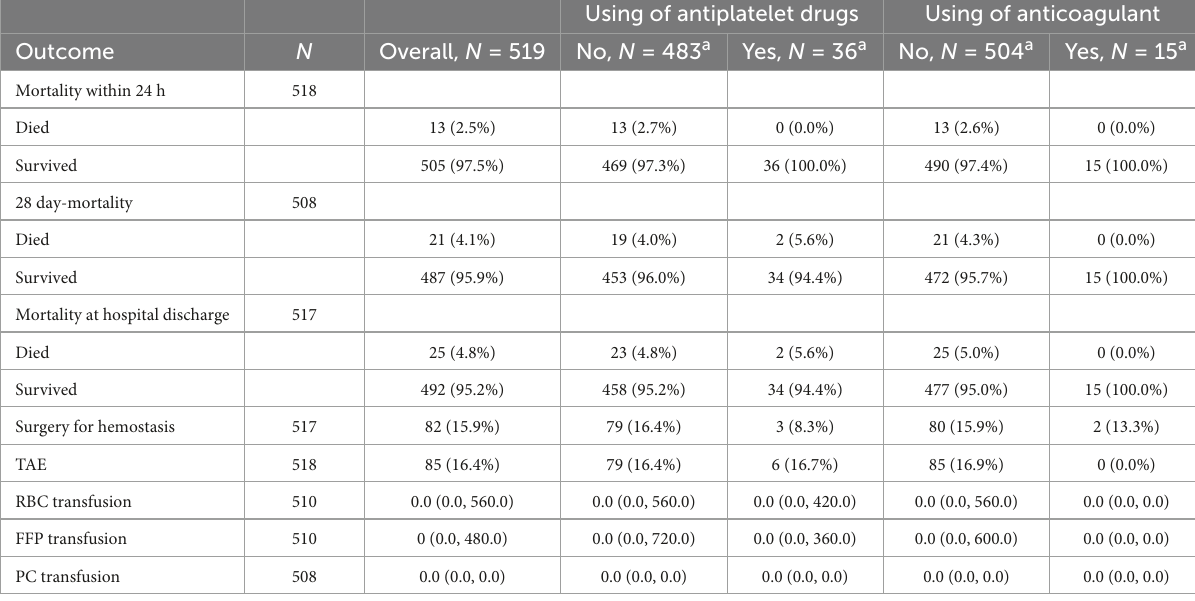
TABLE 3 Outcome variables excluding TBI with abbreviated injury scale of 3 or more points. Using of antiplatelet drugs Using of